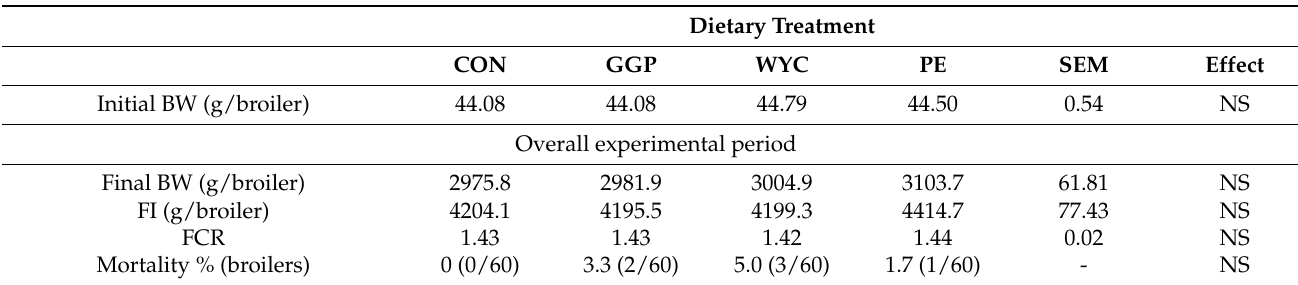
Table 7. Broiler’s growth performance on starter, grower, finisher, and overall experimental period among the four dietary treatments (Control; CON, ground grape pomace; GGP, dried wine lees; WYC, and extract from grape stems included in soluble starch;